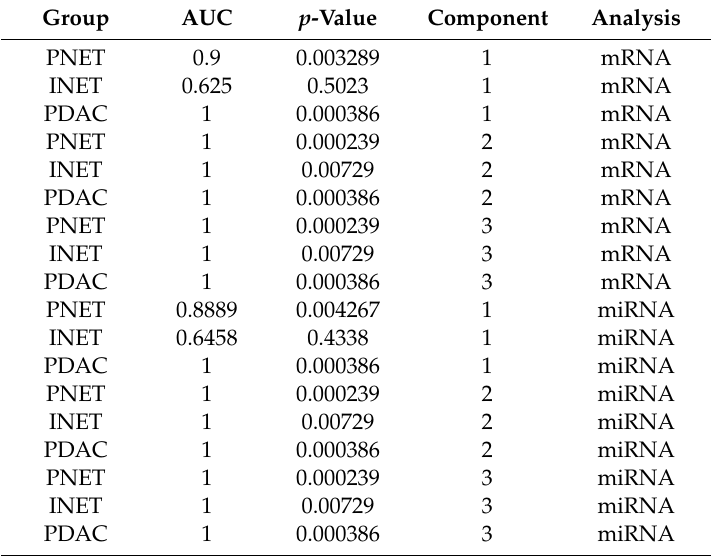
Table 4. AUC (area under the curve) values for the first three components in the PLS-DA Diablo model.